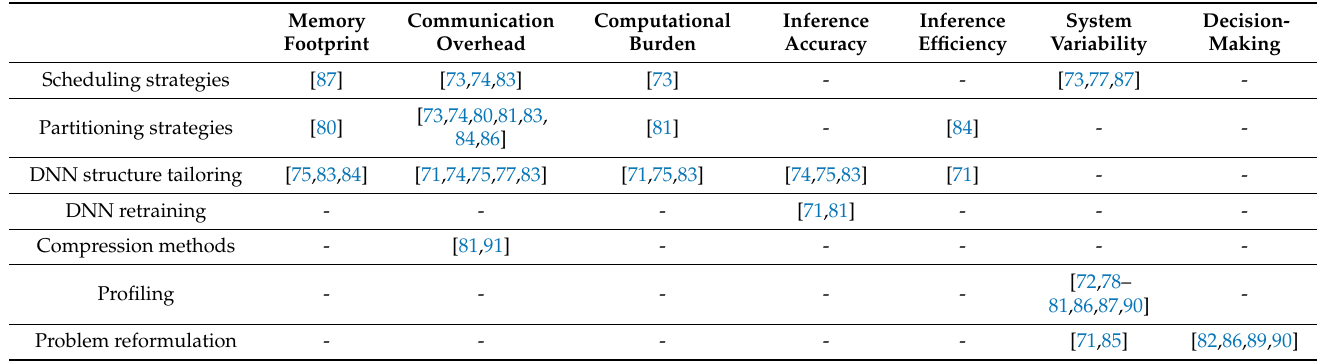
Table 4. Summary of the challenges and approaches conceived in the reviewed